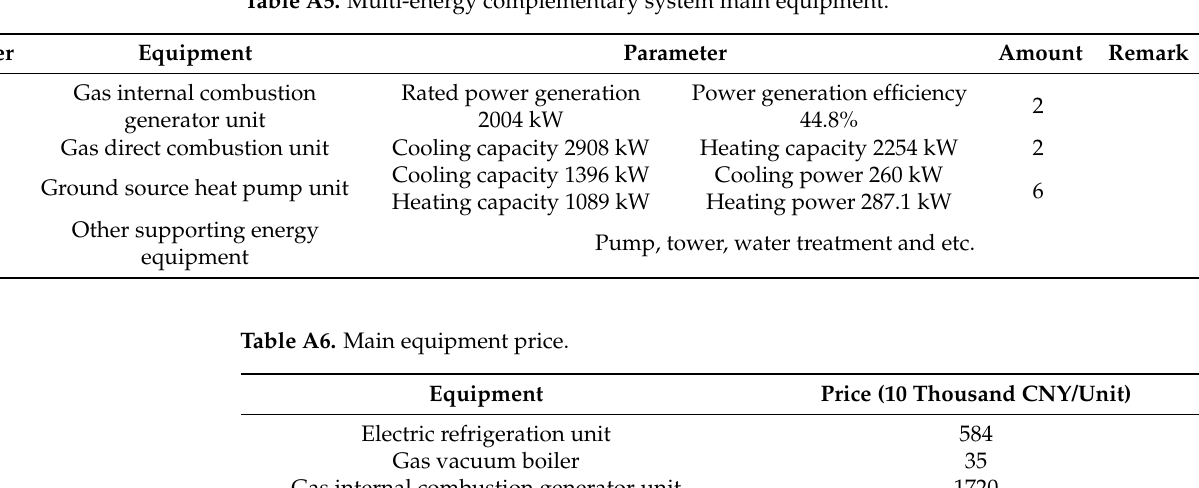
Table A5. Multi-energy complementary system main equipment.